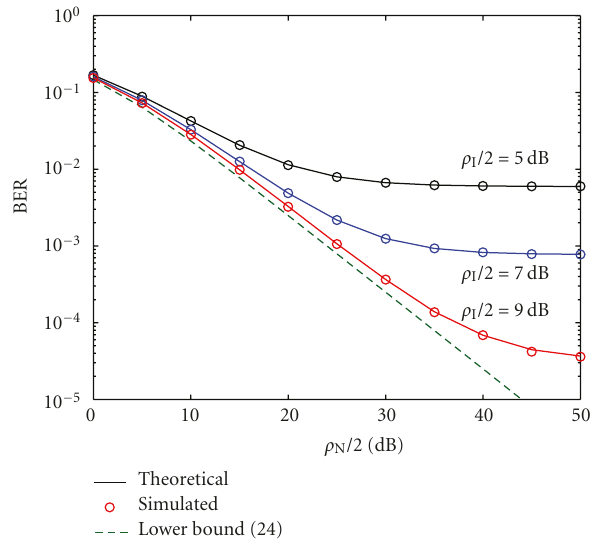
Figure 9: BER in GPS systems with transparent relay ( K =